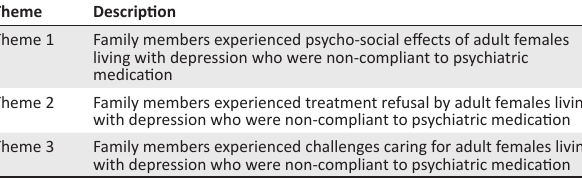
TABLE 2: Experiences of family members’ living with adult females with depression and are non-compliant to psychiatric medication.